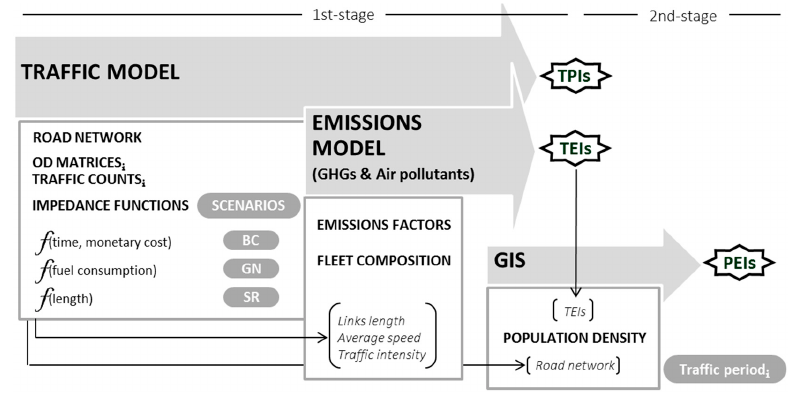
Figure 1. Methodology flow chart.